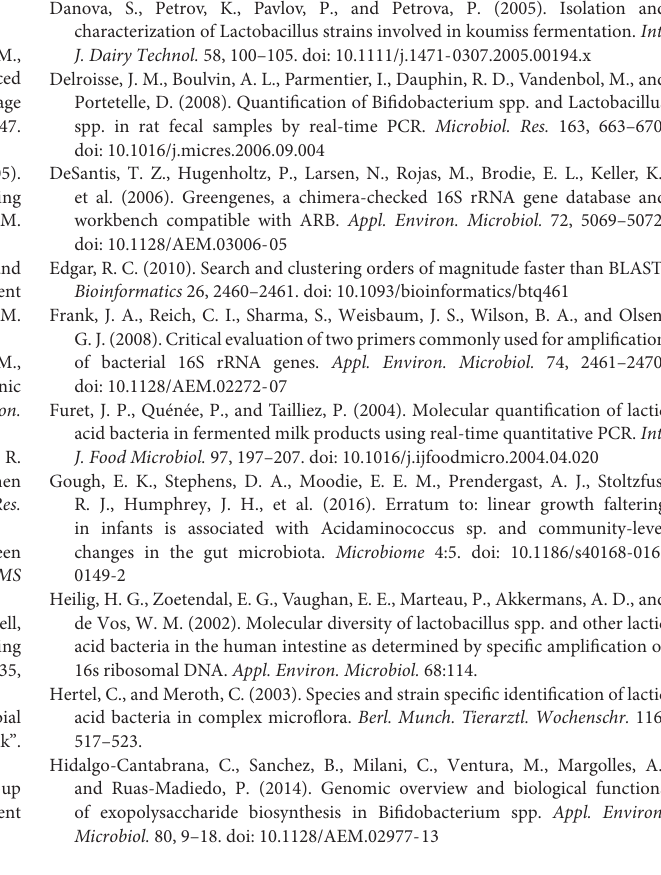
FIGURE S1 | Target LAB diversity in fecal samples amplified using candidate primers. FIGURE S2 | Phylogenetic tree based on 16S rRNA sequences. A total of 347 corresponding 16S rRNA sequences were obtained in LABSEQ. A phylogenetic tree was constructed based on these using TreeBeST software (V1.9.2). Visual trees were then developed using FigTree software